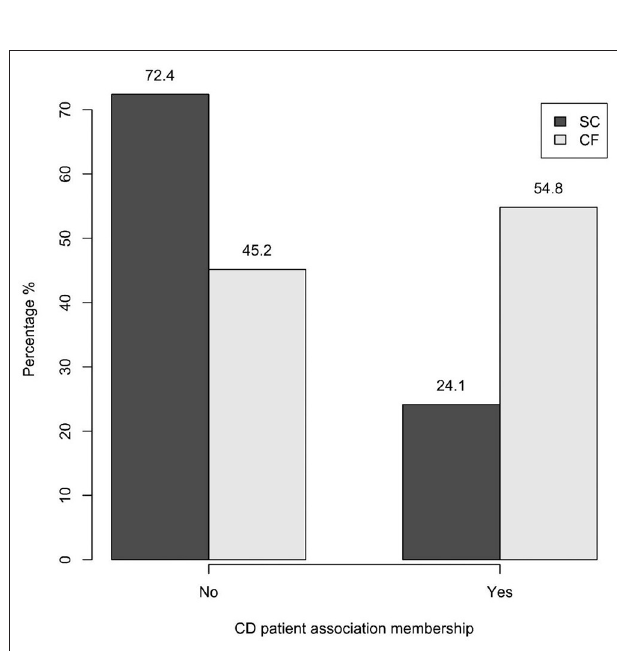
FIGURE 5 | CD patient association membership of the SC-group and of the CF-group ( p = 0.039). SC, screen-detected (group); CF, case-finding (group); CD, celiac disease.